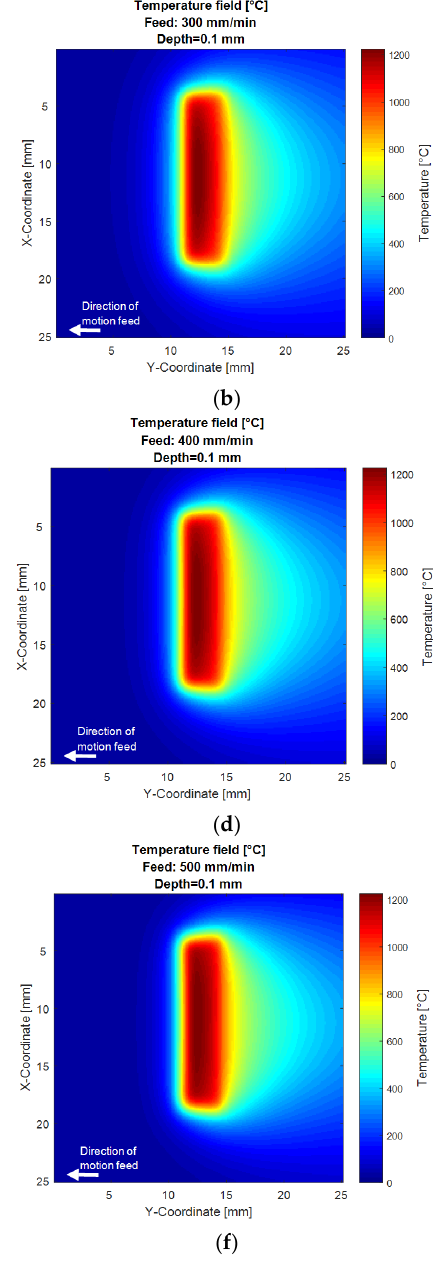
Figure 6. Simulated temperature field at a depth of 0.1 mm in 42CrMo4 (AISI 4140) for a perfect top ‐ hat distribution ( a , c , e ) as well as the optimized profile ( b , d , f ) at a feed of 300 ( a , b ), 400 ( c , d ) and 500 mm/min ( e , f ).